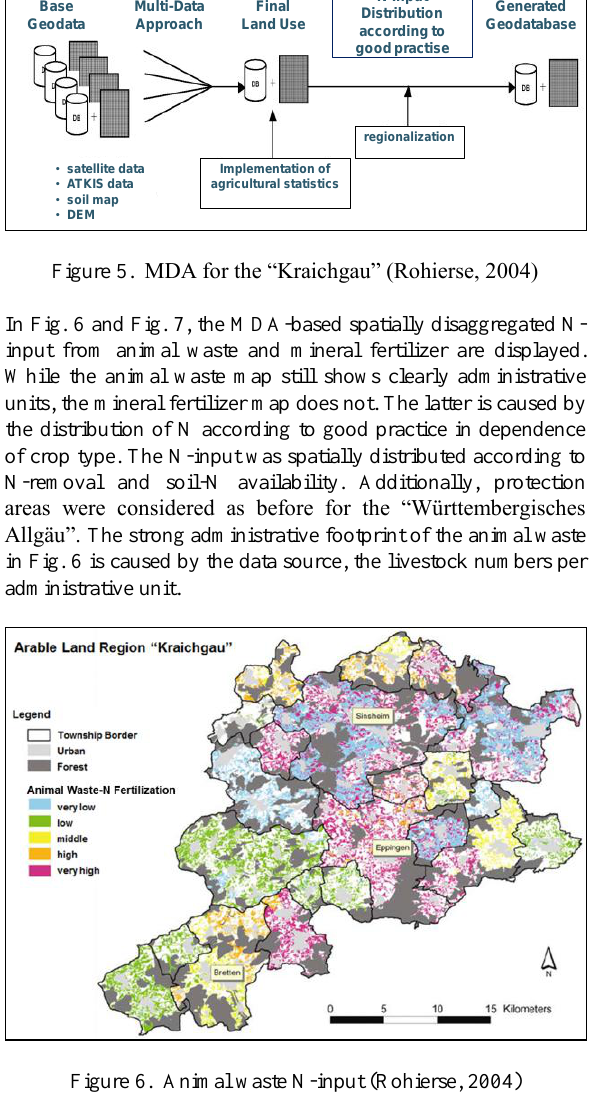
Figure 6. Animal waste N-input (Rohierse, 2004)